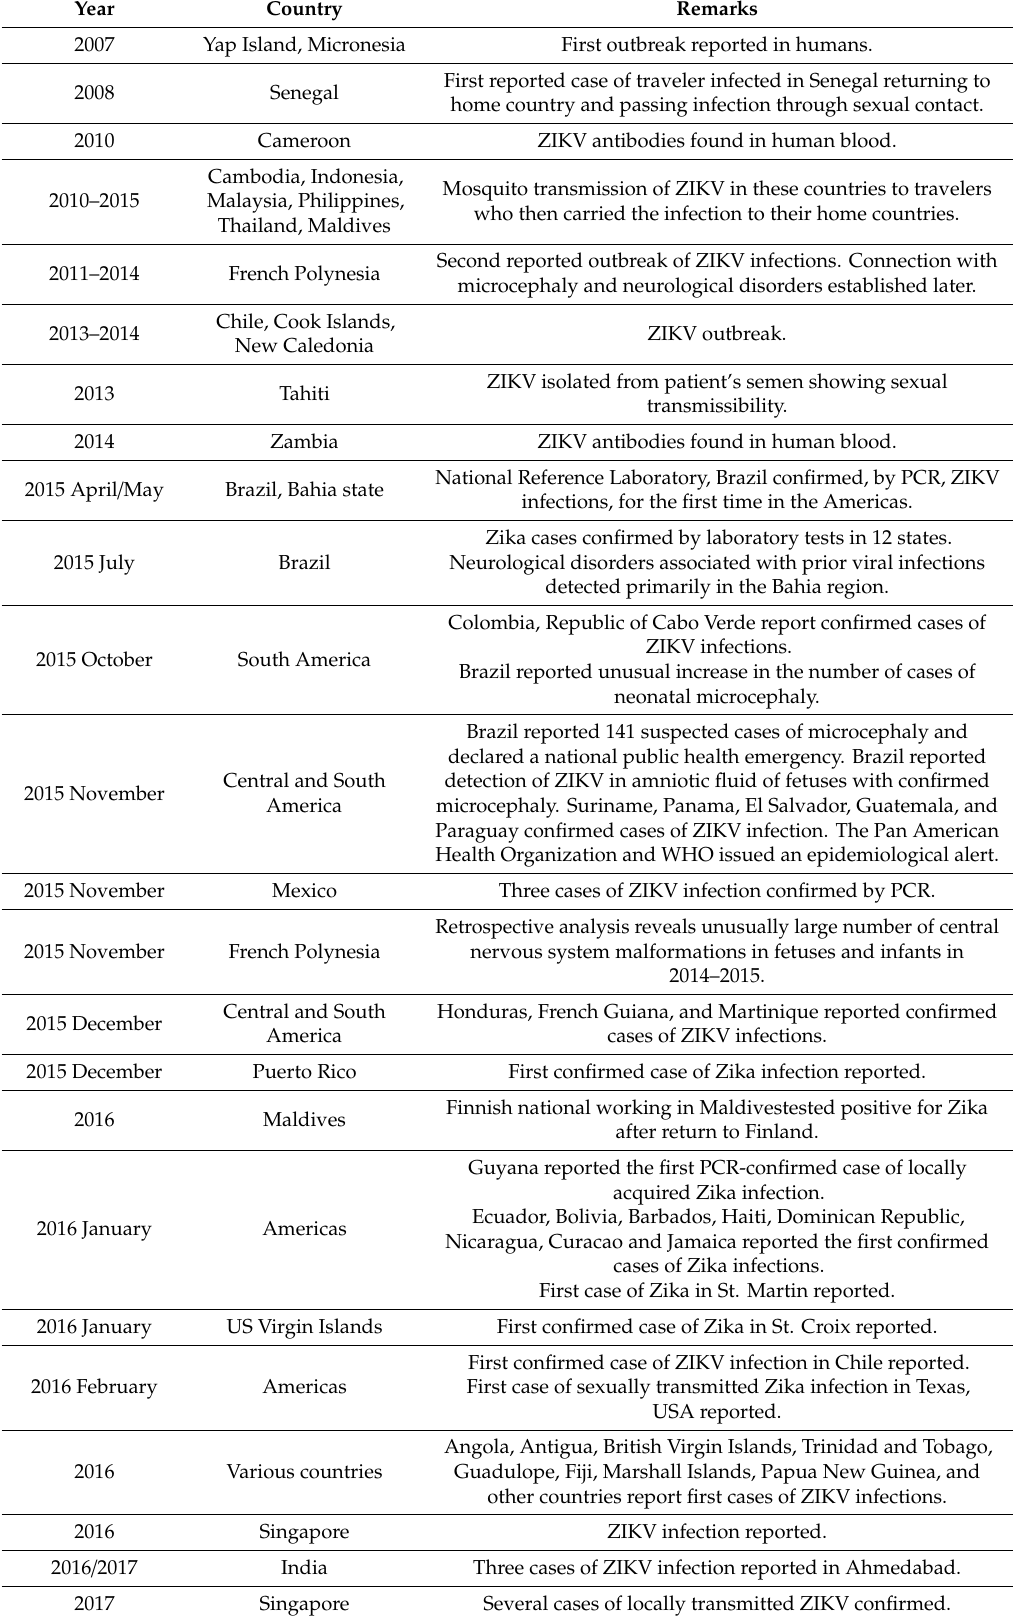
Table 3. A brief summary of ZIKV epidemics, 2007 to present. Data summarized from